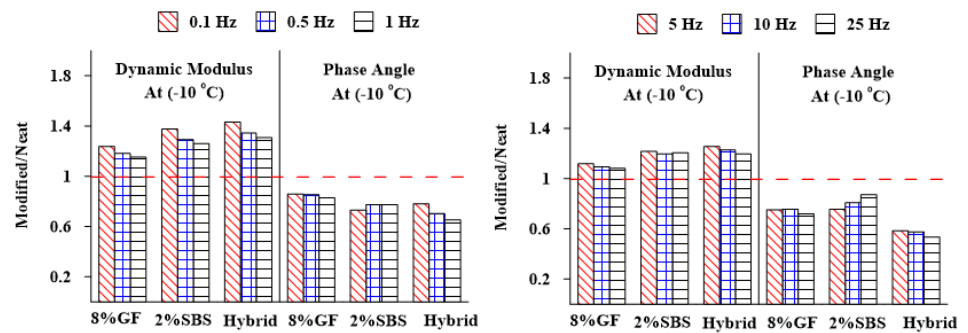
Figure 15. Frequencies’ effects on the E ∗ and δ of different asphalt mixtures at − 10 ◦